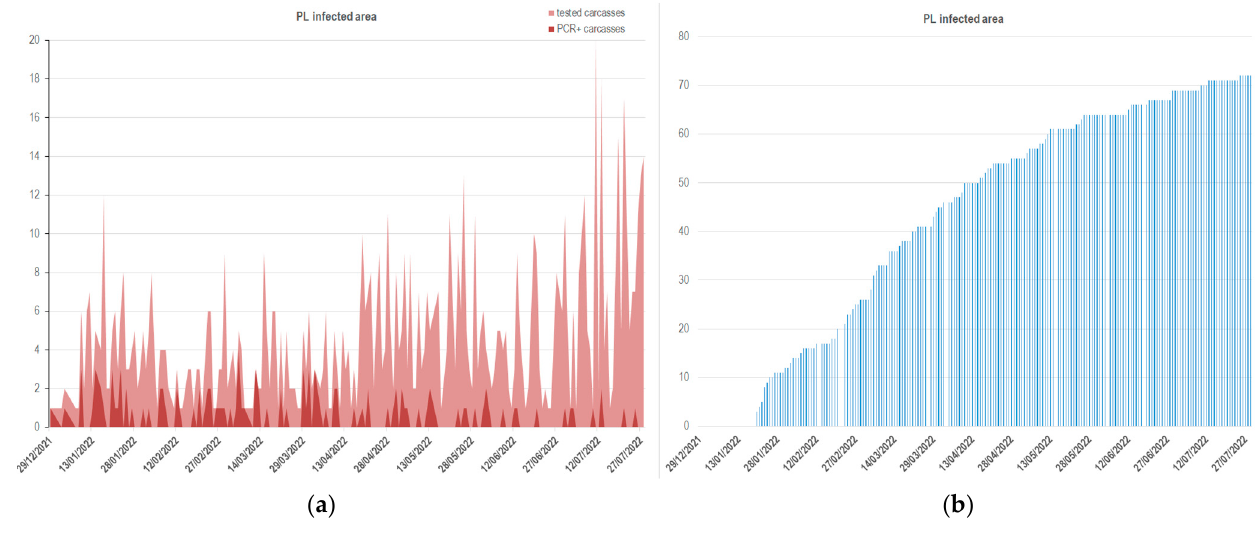
Figure 2. The time series illustrate ( a ) the number of samples from each type of carcass with ASF collected (light red curve) and the number of samples from fresh carcasses tested as PCR+ in Piedmont-Liguria, and ( b ) the cumulated frequencies of these samples over time.